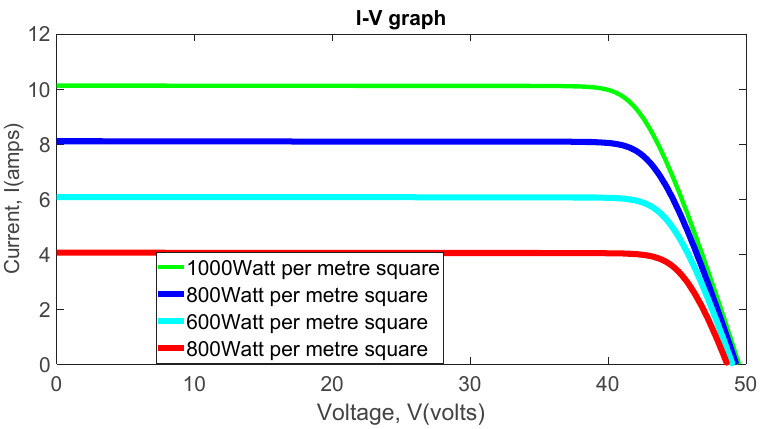
Figure 10. The IV curve obtained from simulation using the Hybrid BESSA technique for Module AS ‐ M3607 ‐ S (G1 CELLS) at varying irradiances while keeping temperature fixed at 25 °C.